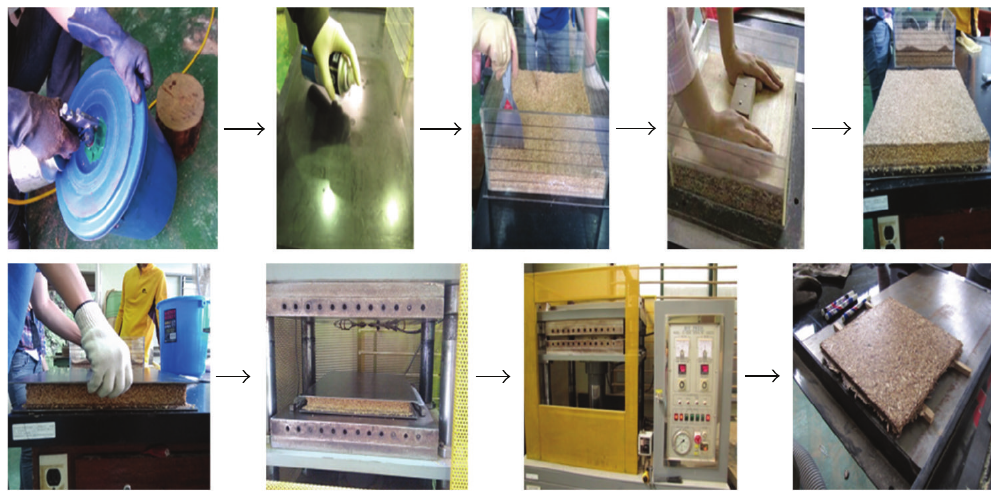
Figure 4: Laboratory-scale production of three-layer particleboards